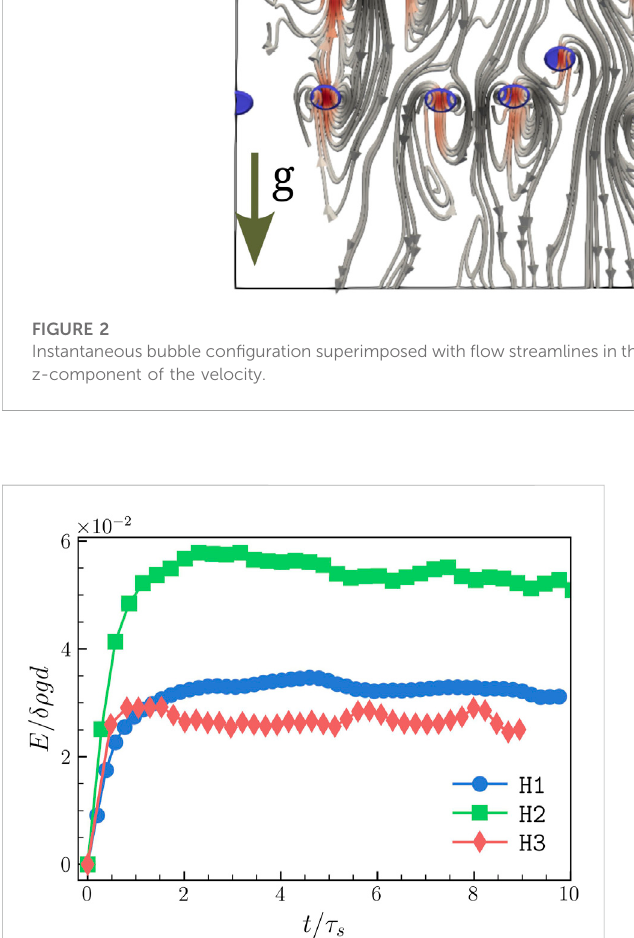
(cid:7)(cid:7)(cid:7) (cid:8) gd